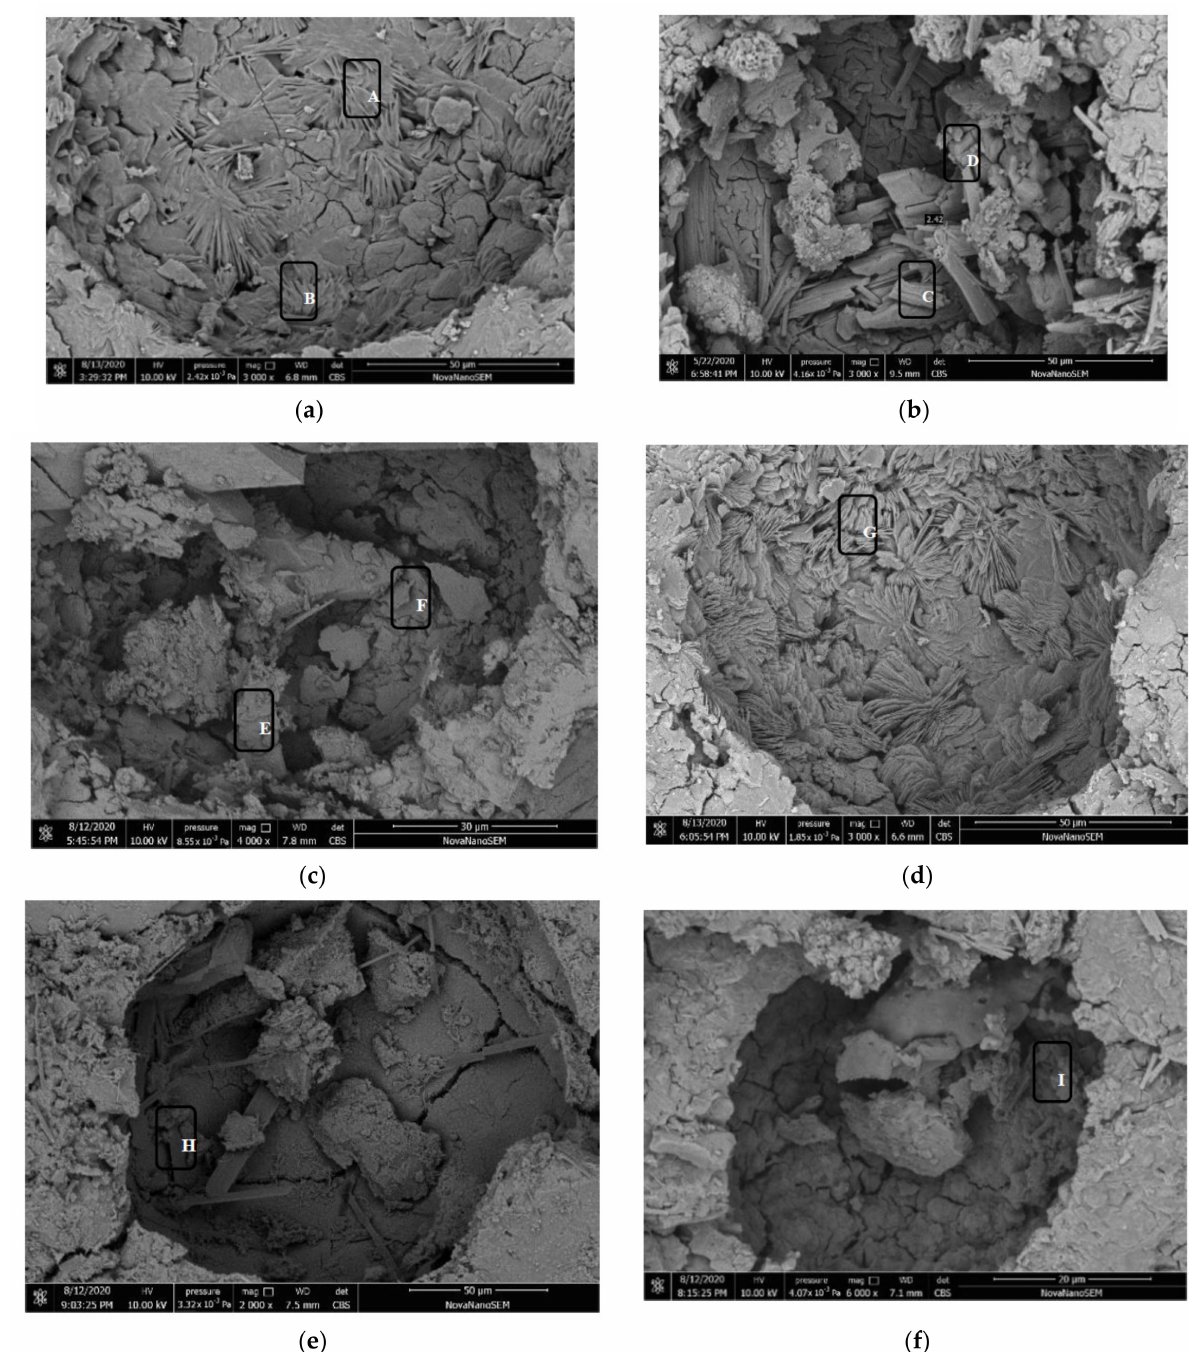
Figure 8. SEM patterns of MKPC mortar samples. ( a ) M-1d before freeze–thaw. ( b ) M-1d after 200 freeze–thaw cycles in water. ( c ) M-1d after 200 freeze–thaw cycles in sulfate solution. ( d )